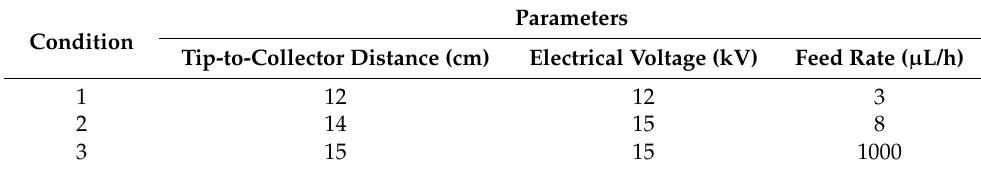
Table 1. Electrospinning conditions used to obtain the cellulose acetate fibers. Condition